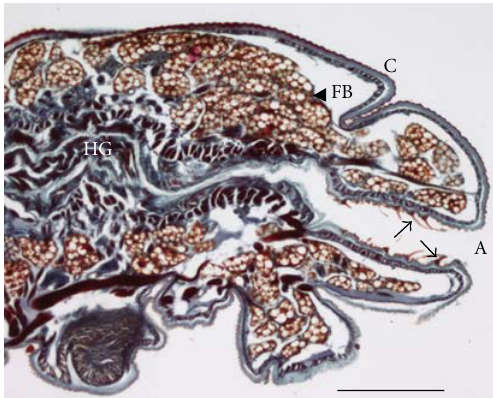
Figure 16: Longitudinal section (dorsal side up) of the posterior end of a N. abietis larva showing the muscular and chitin-lined hindgut (HG), which opens to the exterior through the anus (A). Anal setae are indicated by the arrows. Also visible are fat body (FB) and the exterior cuticle (C) of the larva. Scale bar = 0.2mm.